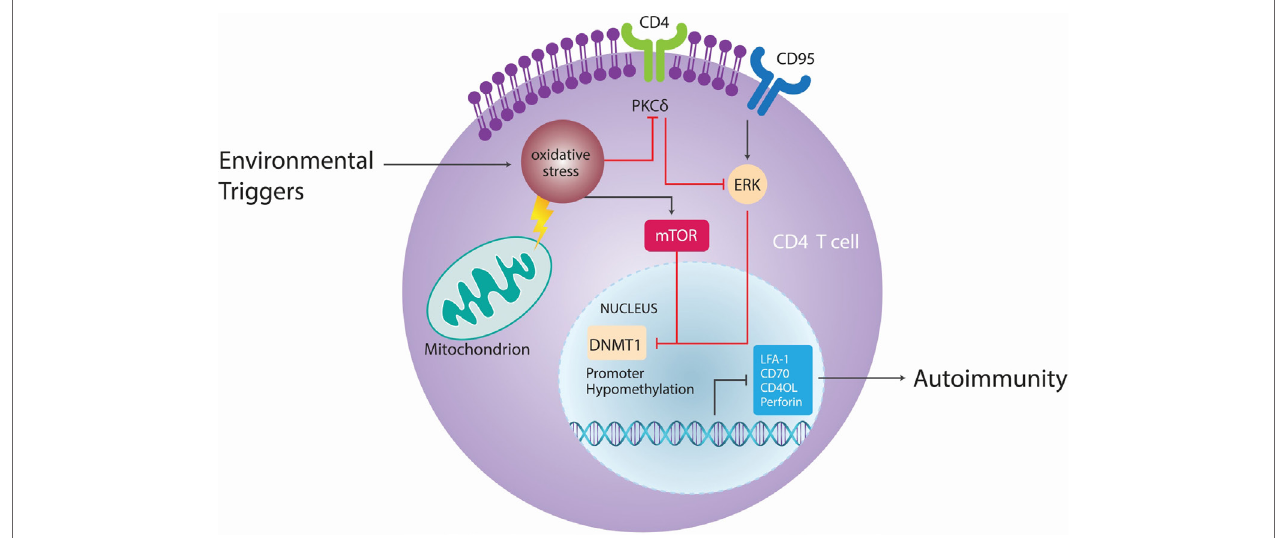
FiGURe 6 | epigenetic autoimmune ecology pathways . Different environmental factors, such as cigarette smoke, chemicals, UV light, and viral infections cause oxidative stress, which lead to activation of the mammalian target of rapamycin (mTOR) pathway that can directly inhibit DNA methyltransferase 1 (DNMT1). Oxidative stress contributes in CD4 + T cells to site-specific decrease in phosphorylation of protein kinase C (PKC) δ T 505 , leading to functional loss of PKC and parallel reduction of extracellular signal-regulated kinase (ERK) phosphorylation. As a result of ERK activity, expression of DNMT1 is reduced, DNA hypomethylation occurs and CD4 + T cells become autoreactive. Adapted from Ref.